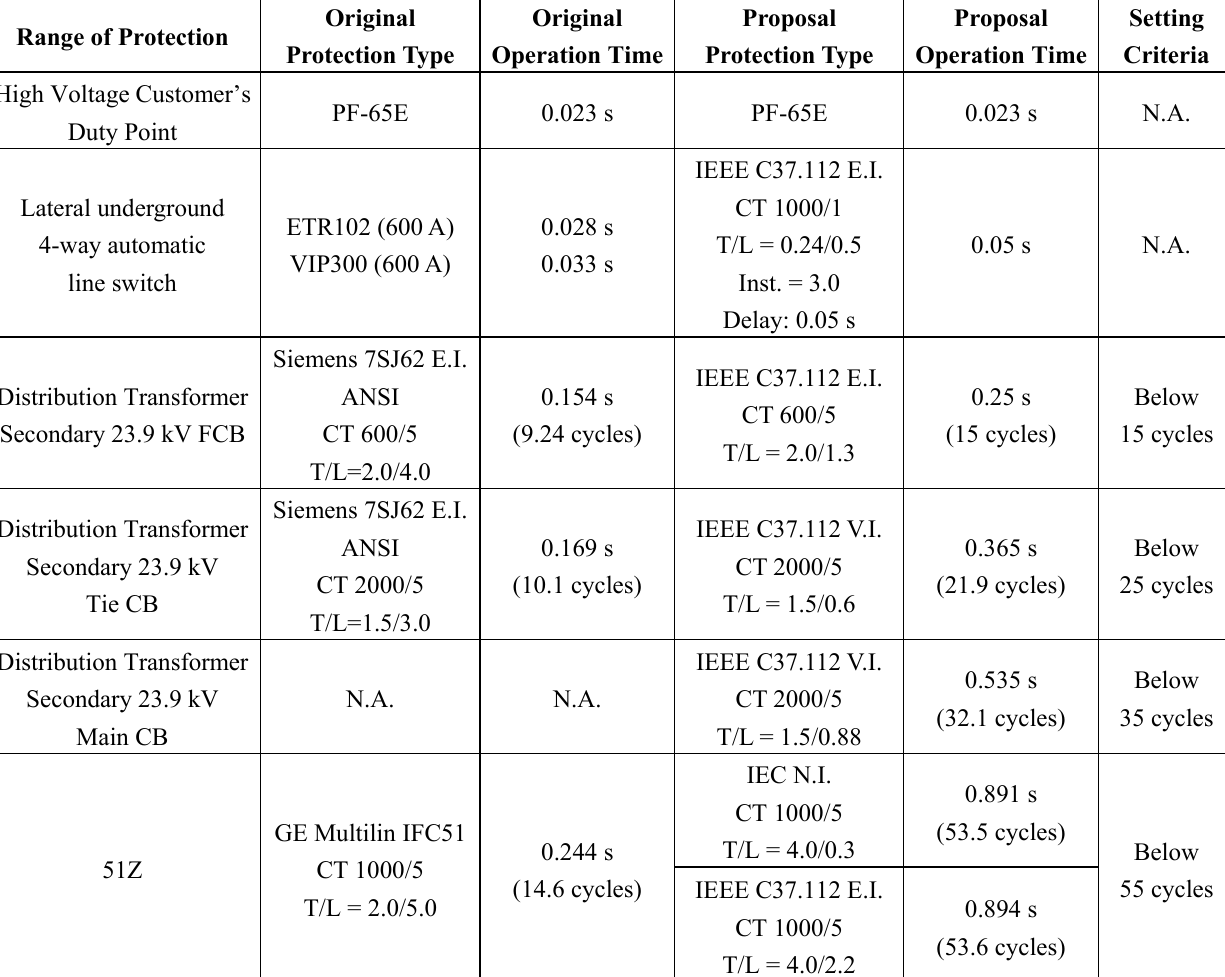
Table 7. Original and proposed LCO relays of Fuyuan